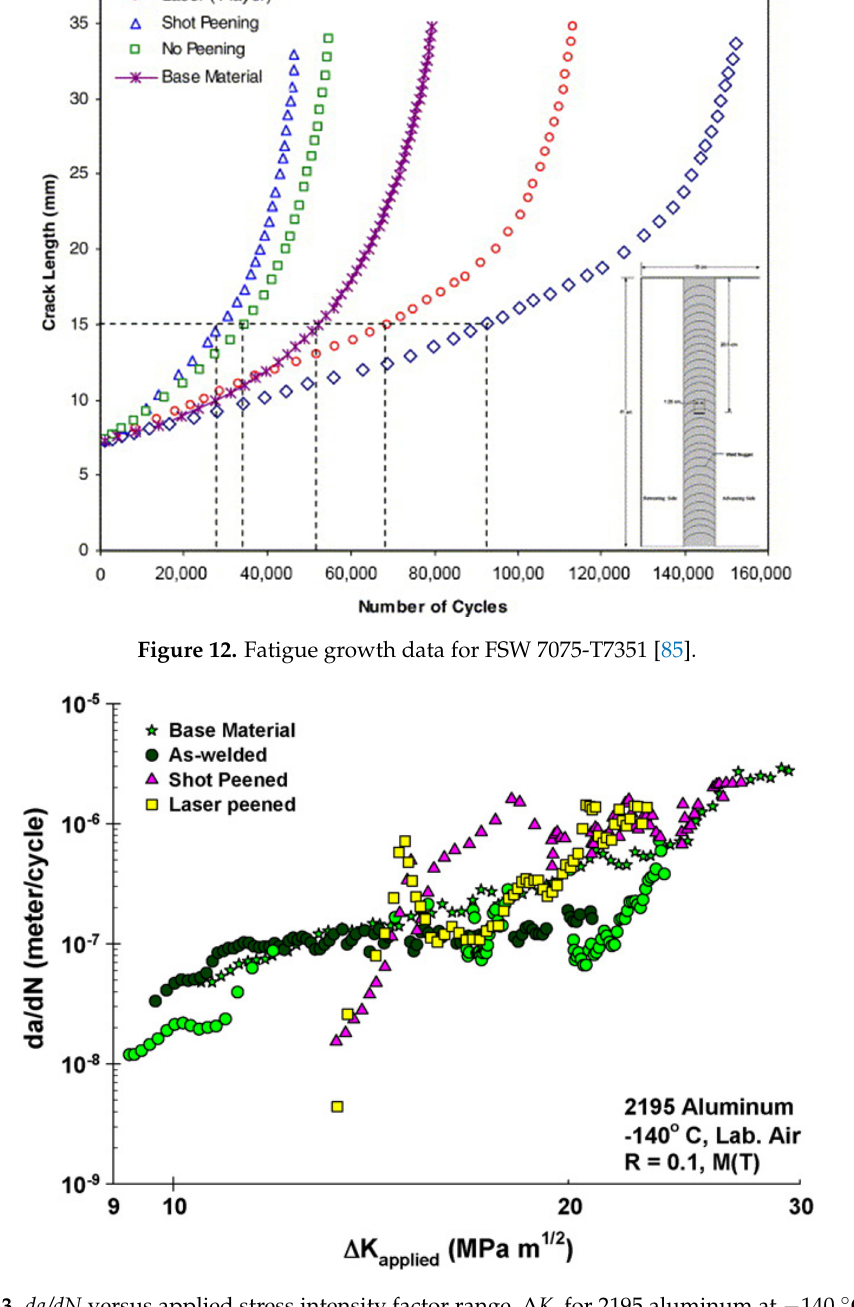
Figure 13. da/dN versus applied stress intensity factor range, Δ K , for 2195 aluminum at − 140 °C [83] .